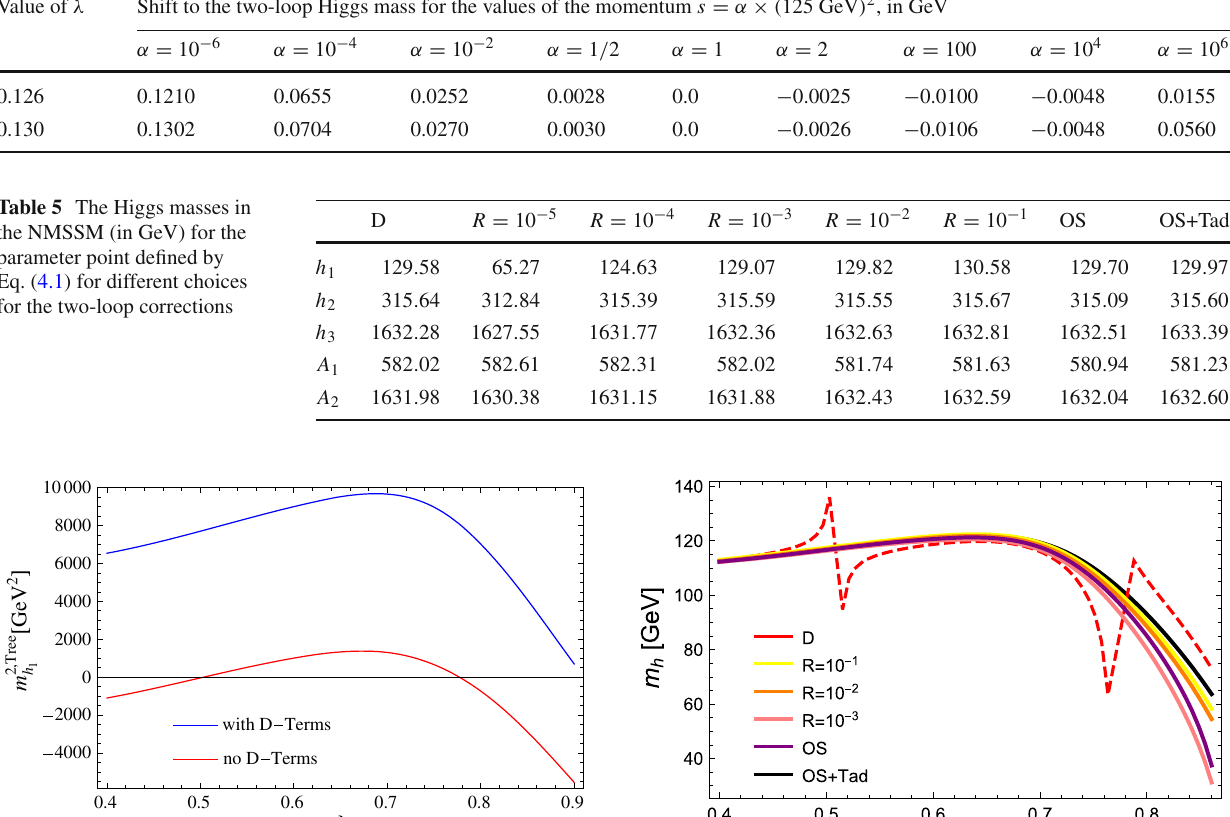
Table 4 Shift in GeV of the two-loop Higgs mass in the Standard Model – computed with SPheno and with respect to the value obtained for p = 125 GeV – for different values of the quartic coupling λ , and of the incoming momentum s in the two-loop routines Value of λ